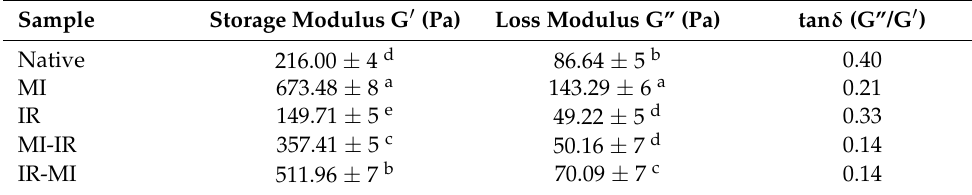
Table 4. Dynamic rheological properties of native and modified lotus rhizome starches.